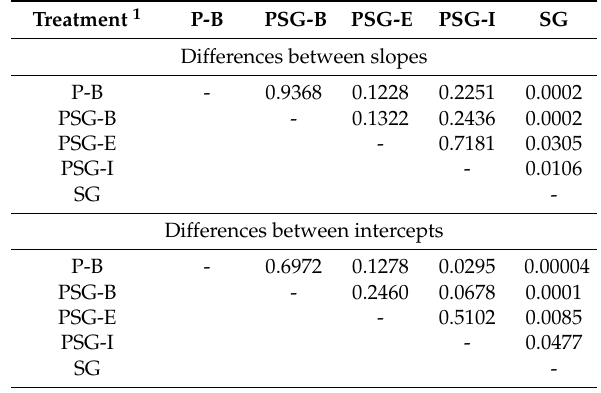
designations indicate the microtopographical position of the sample location where B = bedded row, I = interbed